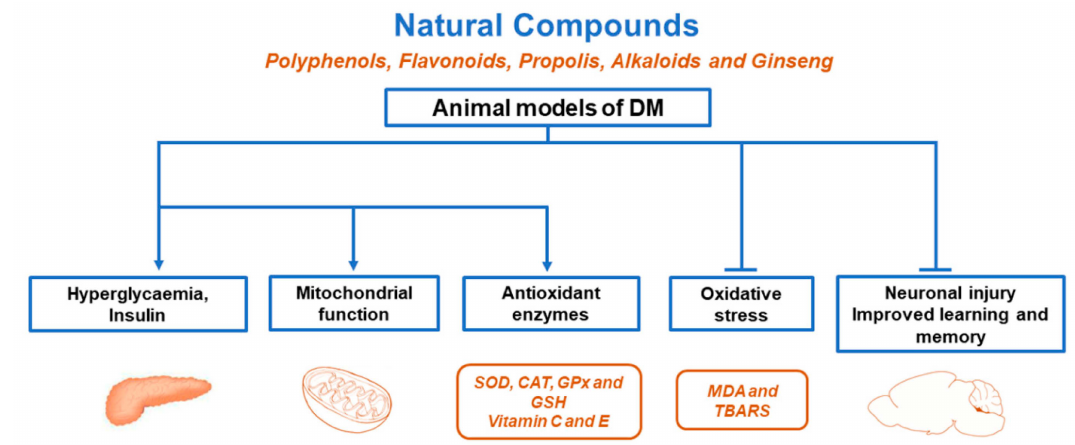
Figure 1. Protective effects of various natural compounds in animal DM models. Natural compounds prevented hyper- glycaemia, ROS production, and neuronal injury; increased insulin secretion and antioxidant enzymes; and improved mitochondrial function, learning, memory, and lipid metabolism, among